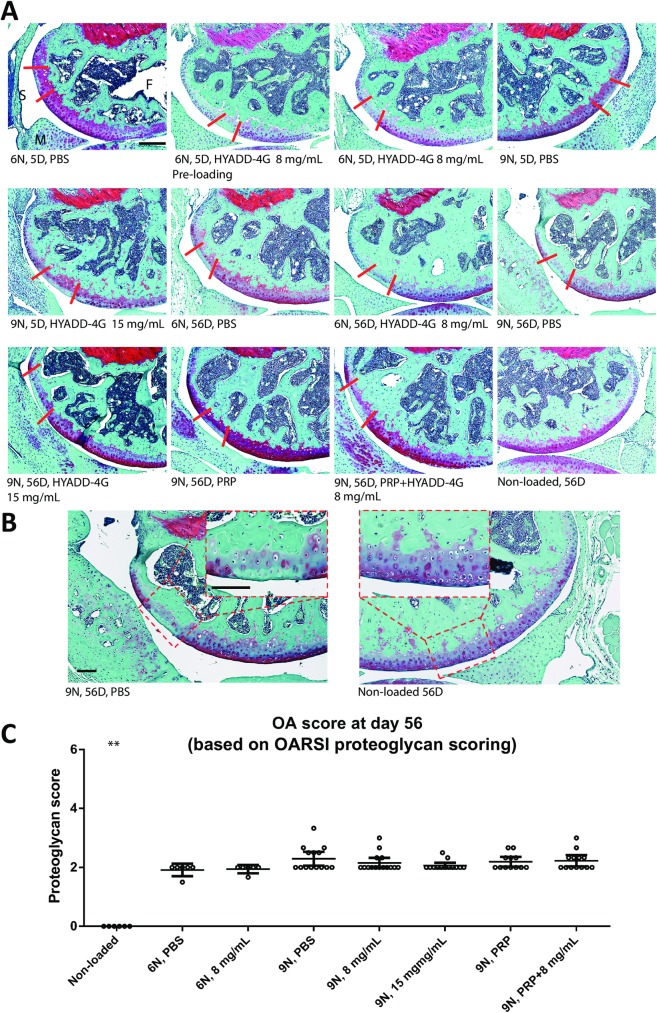
Cartilage injury.Representative images of cartilage injury of the lateral femoral condyle in each group showing loss of Safranin-O staining and absence of normal nuclear staining are provided for higher (A) and lower (B) magnification. There was no therapeutic effect of HYADD® 4-G or PRP on cartilage injury and results were not different from PBS treatment. The area between two red lines in each image shows the injury site of each knee. OA scored based on proteoglycan loss on day 56 after loading showed that there was no significant effect of any treatment modality on proteoglycan replacement (C). Bar = 50 μm, ** indicates P < 0.01 compared with other groups. Error bars represent 95% confidence interval. PBS = phosphate buffered saline, PRP = platelet-rich plasma, F = femur, M = meniscus, S = synovium.